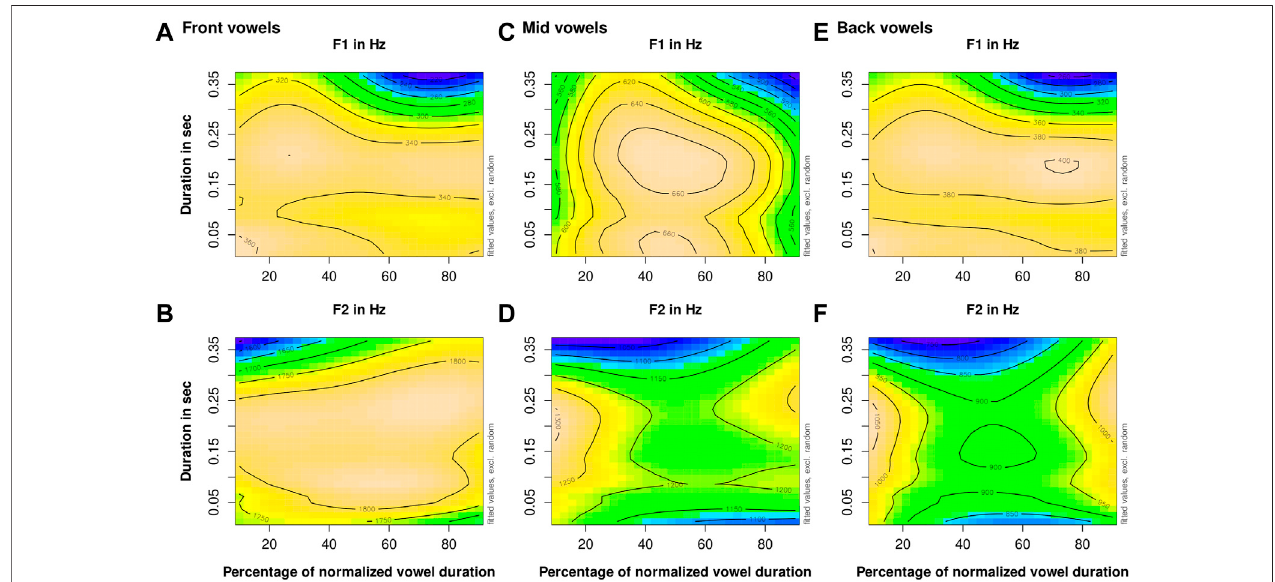
FIGURE 8 | Stressed vowels: heatmap of the interaction of the vowel duration and measurement point on the trajectory of the fi rst formant (A) and the second formant (B) per the vowel categories front (C) , mid (D,E) , and back (F) .